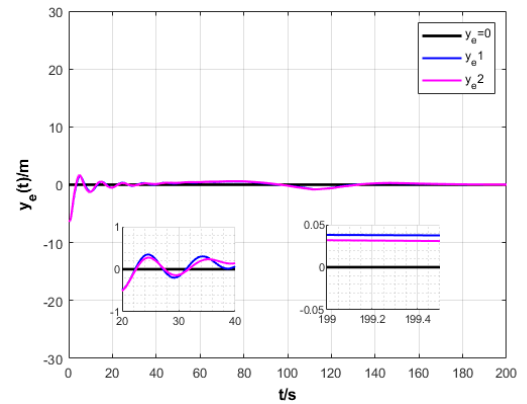
Figure 11. Transverse error variation of USV under two strategies.